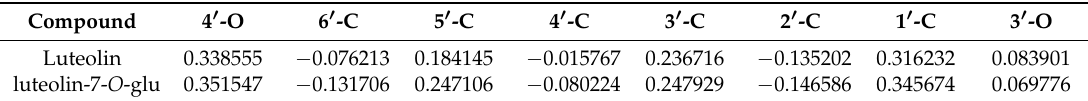
Table 4. The C-ring’s spin density of luteolin and luteolin-7- O -glu.